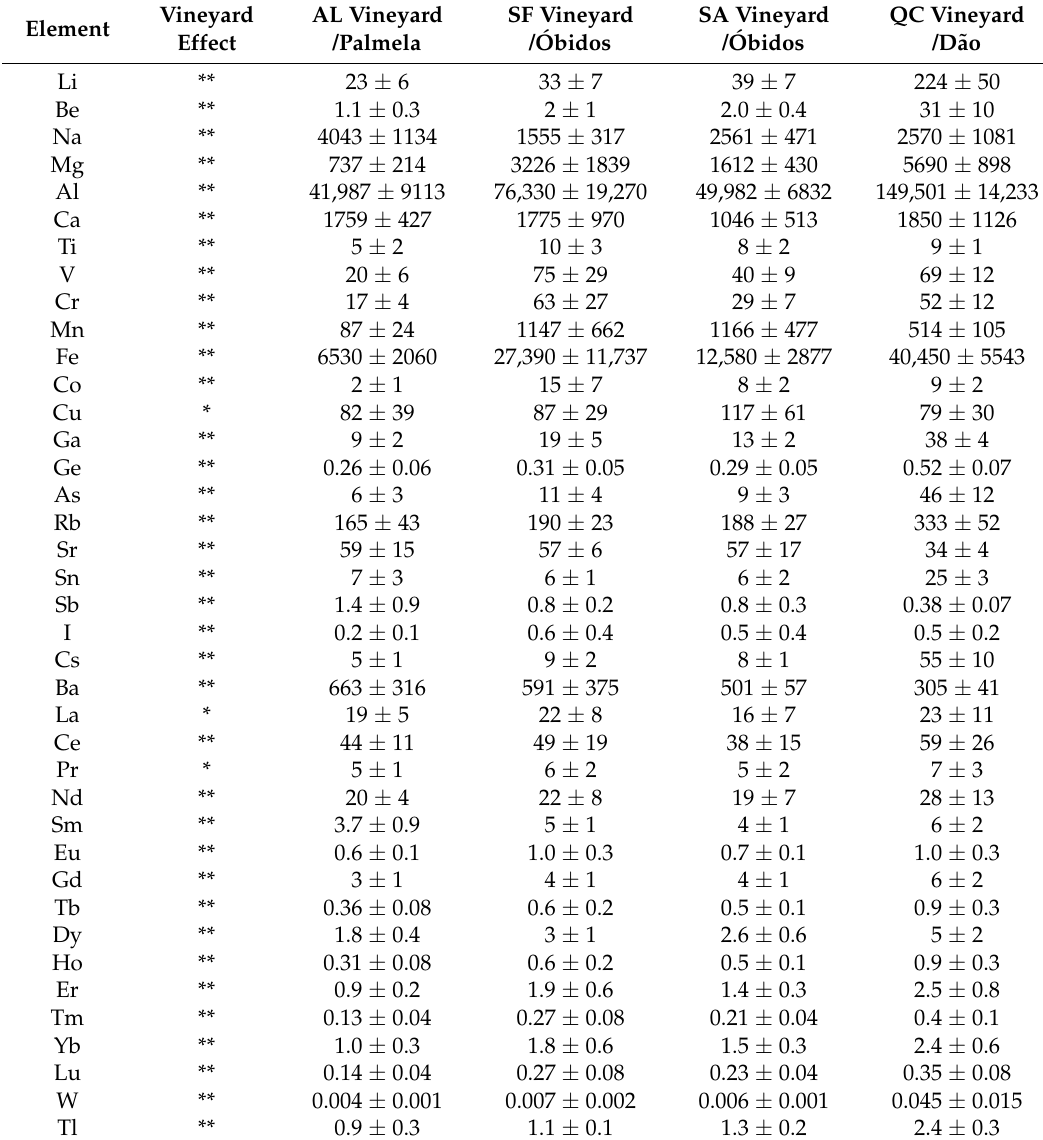
Table 2. Multi-elemental composition ( µ g/g) of soils of the different vineyards. Average concentration (mean ± standard deviation). (AL) Vinha de Algeruz; (SF) Quinta de S. Francisco; (SA) Quinta do Sanguinhal; (CQ) Quinta dos